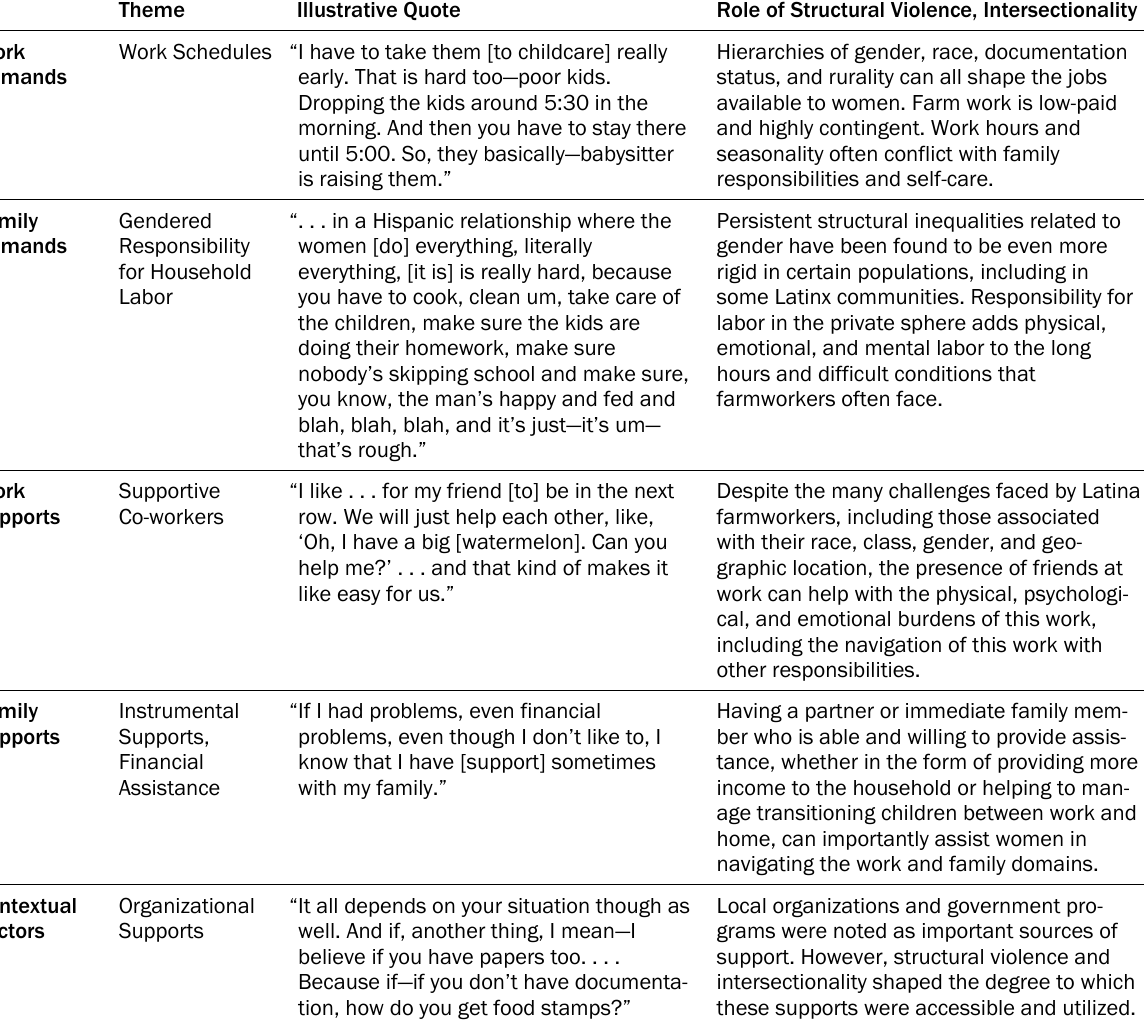
Table 1. Summary of